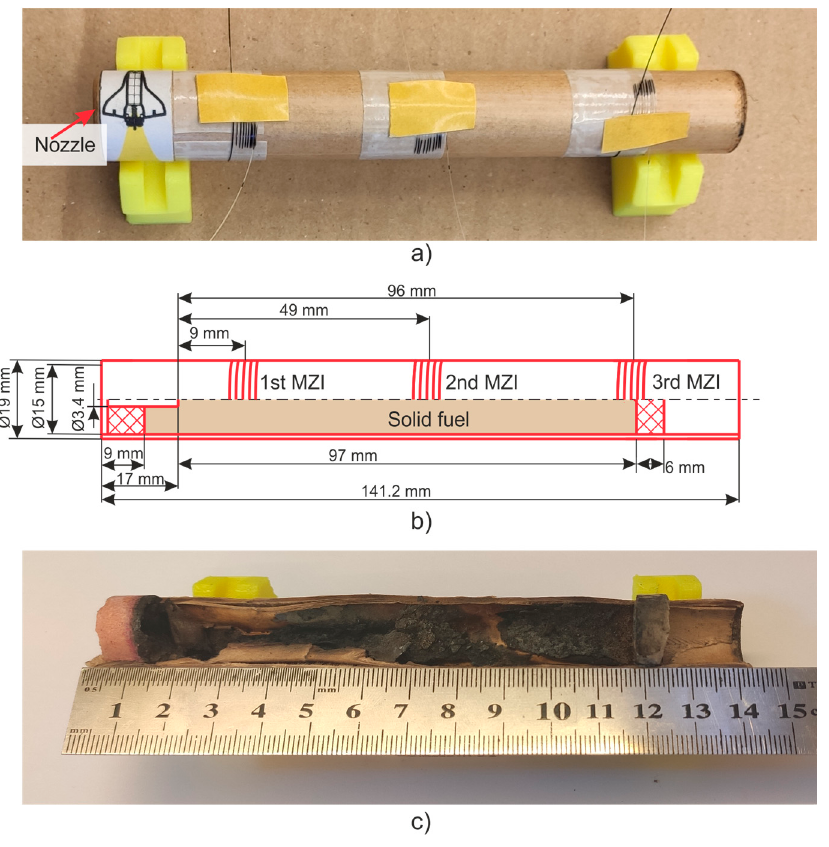
Figure 3. View of the model SRM E-5-0 with installed MZI ( a ), a diagram with dimensions between the main SRM components and the MZI ( b ), and the SRM section after work ( c ).